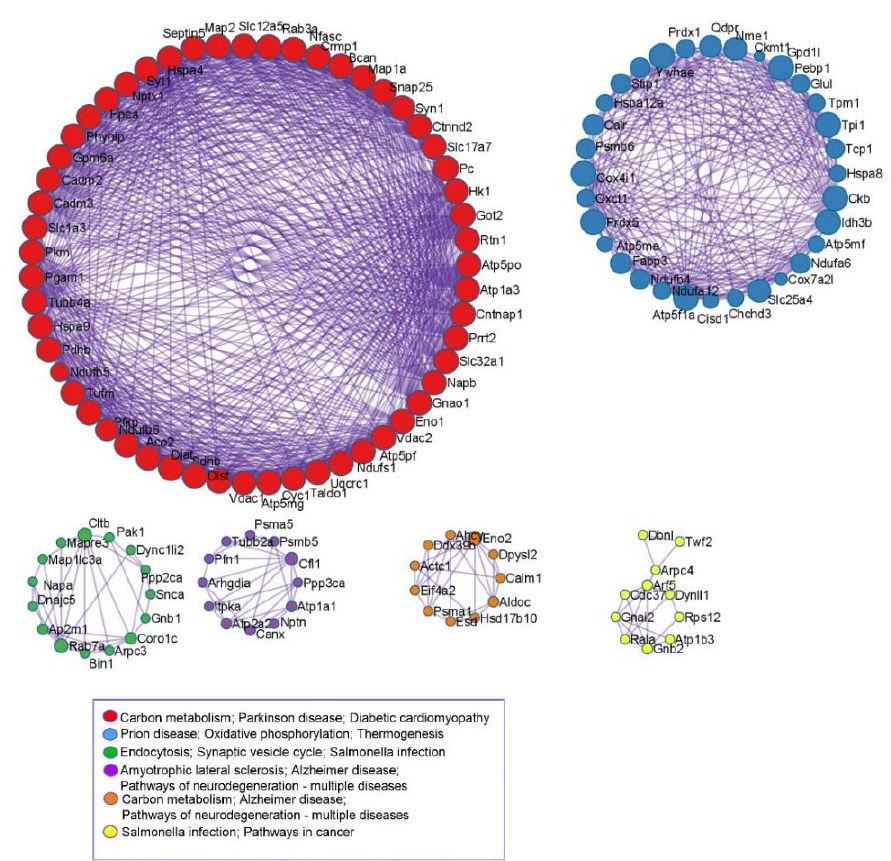
Figure 5. Protein–protein interaction (PPI) networks visualized by Cytoscape software (Institute Figure 5. Protein – protein interaction (PPI) networks visualized by Cytoscape software (Institute for for Systems Biology, Seattle, WA, USA). All protein–protein interactions among input genes were Systems Biology, Seattle, Washington, USA). All protein – protein interactions among input genes extracted from PPI data source and formed a PPI network. GO enrichment analysis was applied to the network to extract “biological meanings”. Then MCODE algorithm was applied to this network to identify neighborhoods where proteins are densely connected. The explanation of abbreviations of proteins are listed in Supplementary Data